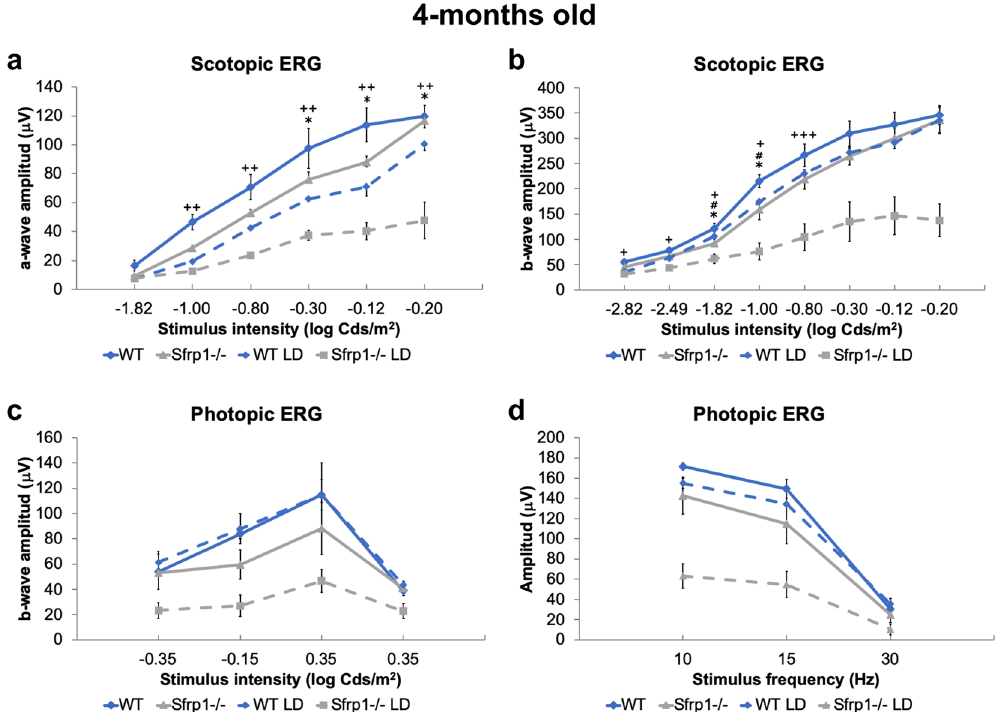
Figure 7. Loss of SFRP1 reduces the ERG response after light-induced damage in the Rpe65 Leu450Leu variant. ( a , d ) The graphs show the a- and b-wave amplitude ( µ V) of the scotopic (rods and rod bipolar cells, a , b ) and photopic (cones and cone bipolar cells, c, d) ERG response from 4 months-old WT and Sfrp1 − / − animals to flash light stimuli of increasing brightness (cd/m 2 ). Kruskal Wallis with post hoc Dunn. * indicates significant difference between Sfrp1 − / − untreated and light-damage mice. #indicates significant difference between Sfrp1 − / − and wt animals exposed to light damage. + Indicates significant differences between Sfrp1 − / − and wt untreated mice. No significant differences were found between untreated and light-damage wt mice. * p < 0.05, ** p < 0.01, *** p < 0.001. Abbreviations: ONL: outer nuclear layer; OPL: outer plexiform layer; OS outer